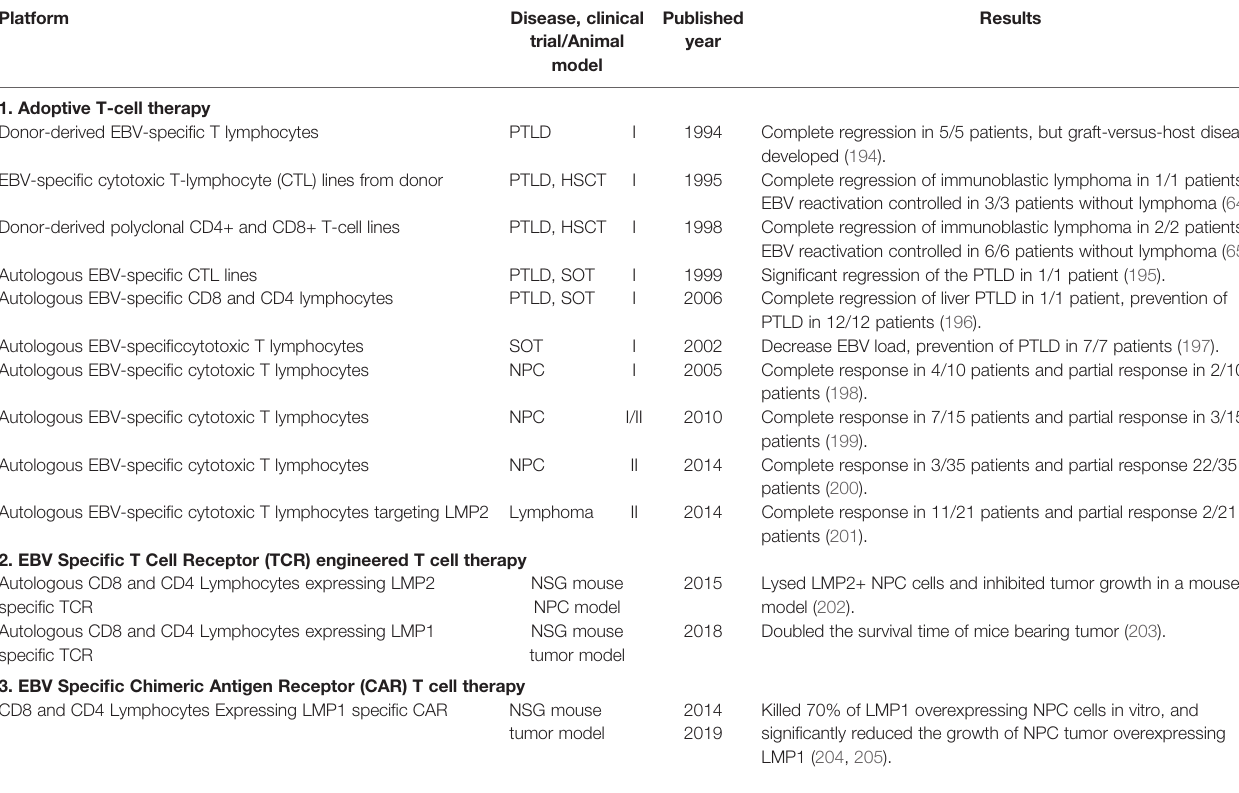
TABLE 3 | Summary of EBV immune cell therapies. Platform